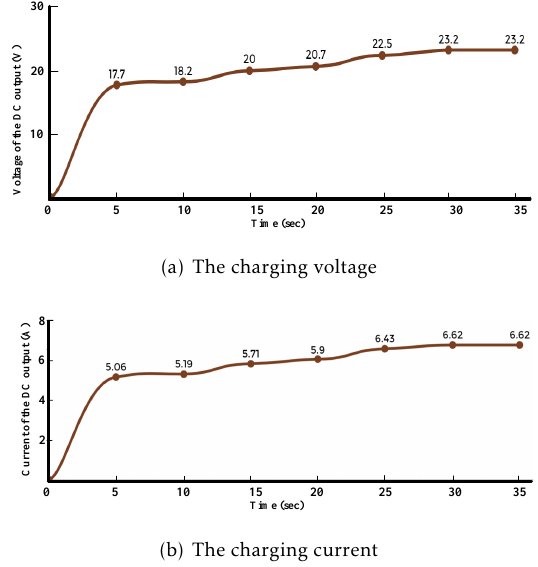
Figure 10. The output values of the hybrid system